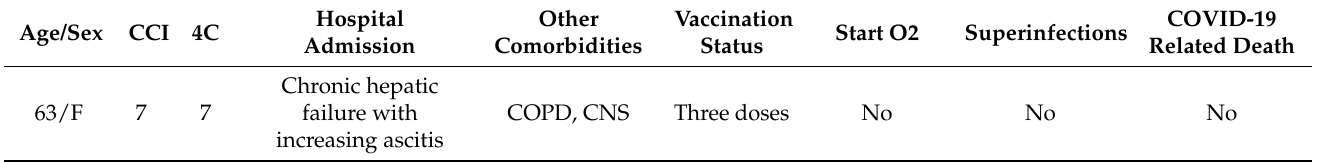
Table 5. Patients’ characteristics of deceases